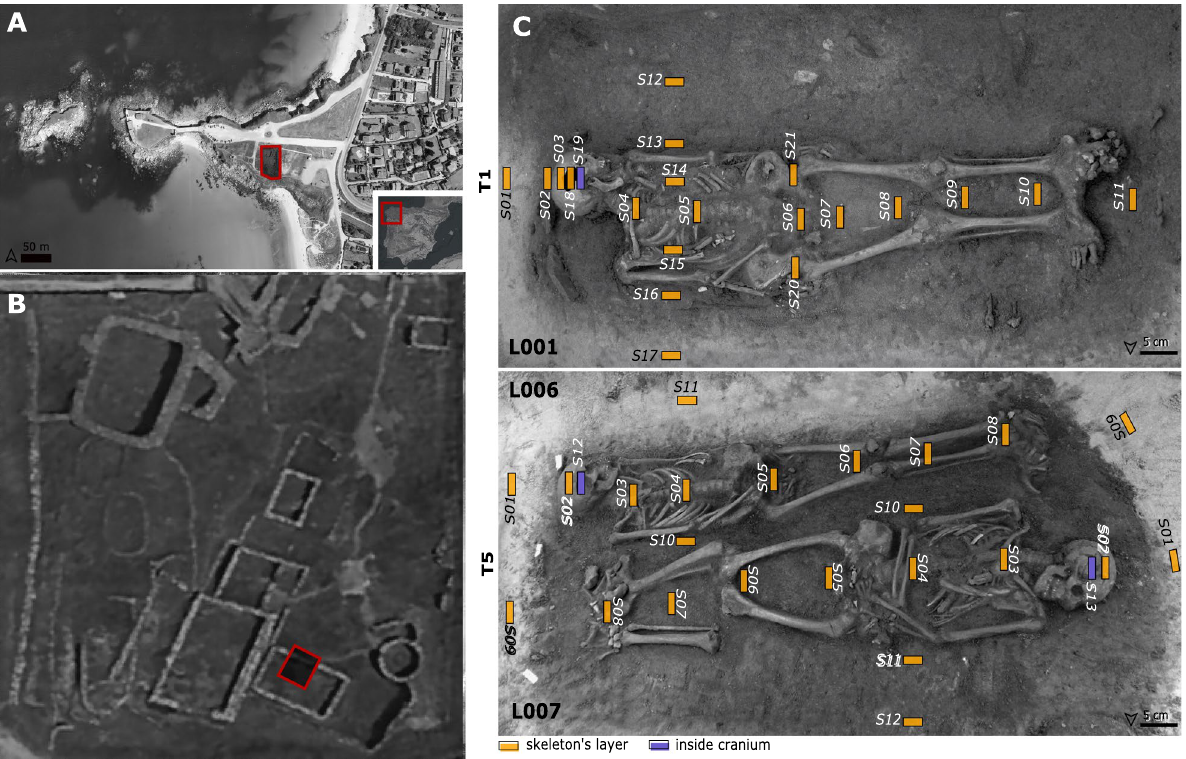
Figure 4. ( A ) and ( B ) Aerial view of A Lanzada with the approximated situation of the graves ( A ) modified from 79 , https:// bit. ly/ 3FwpZ rE; (B) modified from 80 , https:// bit. ly/ 3BBqx Ky. ( C ) Sampling model. In T1 the gray arrow represents the organic matter flow from inside the tomb to the surrounding